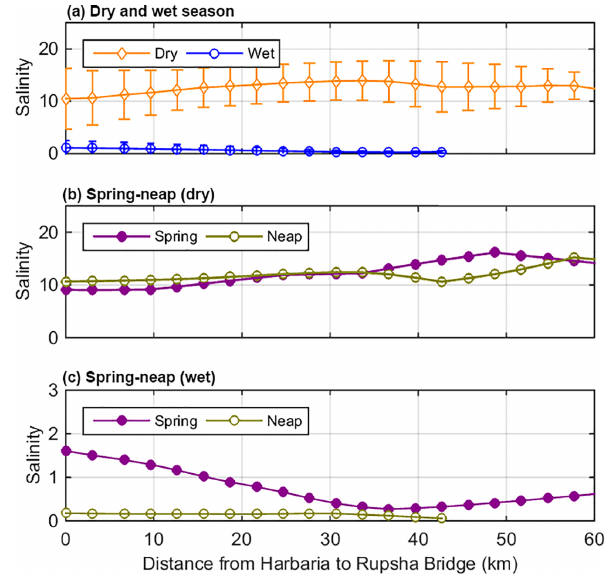
Figure 4. Depth-averaged salinity distribution at high water during neap and spring tides in the Pasur River estuary in the wet and dry